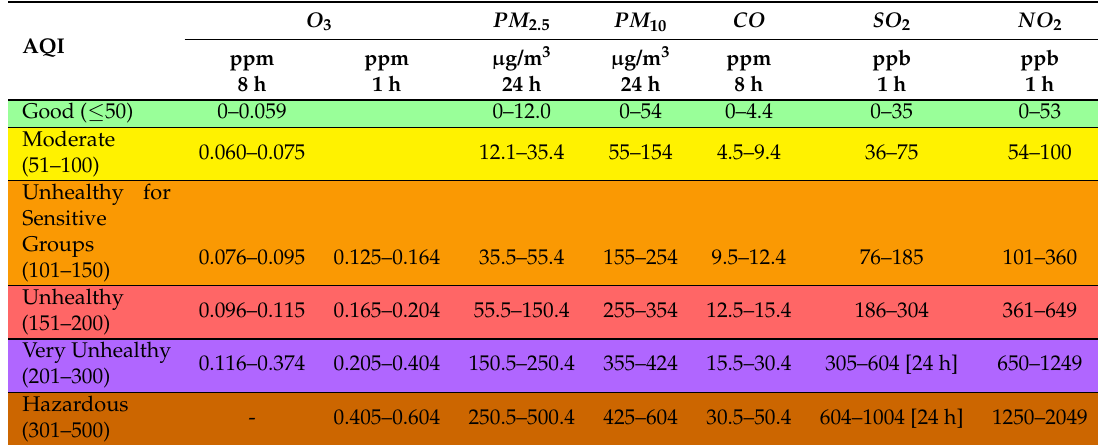
Table 2. Unit of measure, observation period and breakpoints for major air pollutants used in AQI computation.